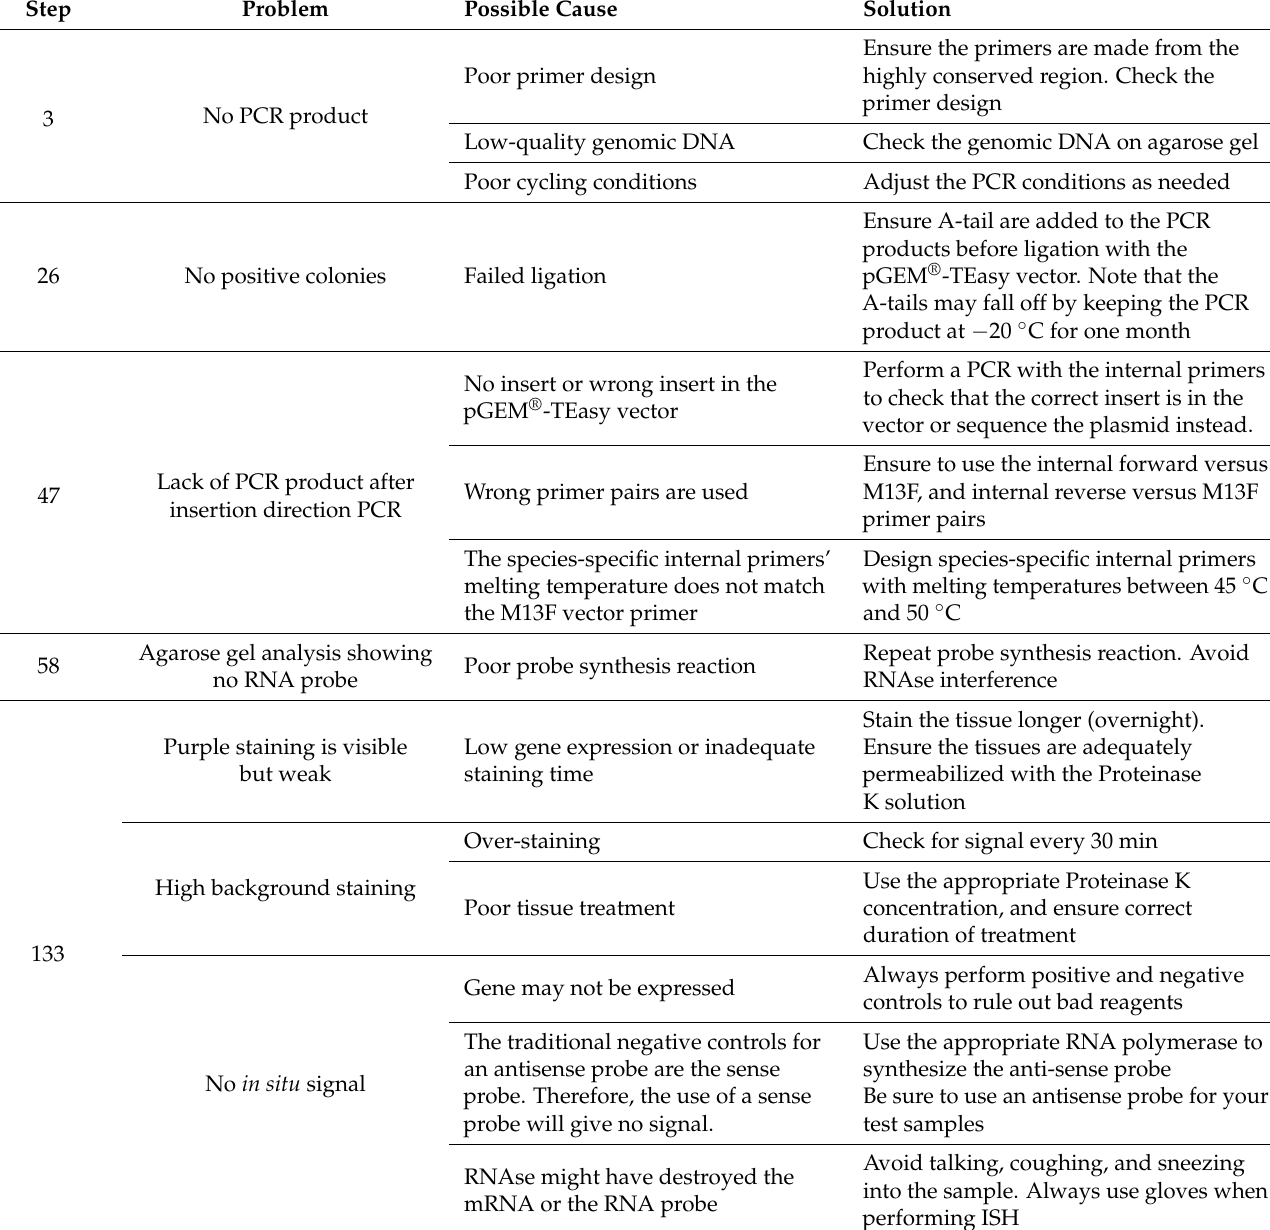
Table 12. Troubleshooting guide. A table summarizing the problems that we have encountered in the past with appropriate actions to solve each